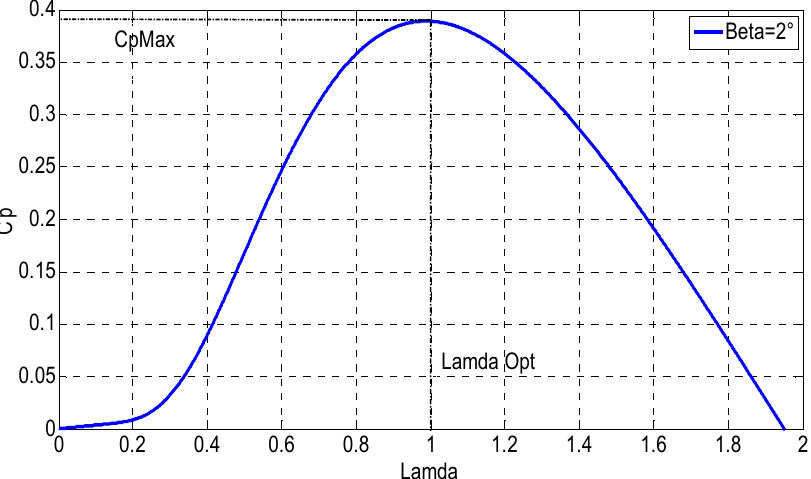
Figure 7. Variation of the power coefficient Cp with respect to the tip speed ratio λ for β = 2°.